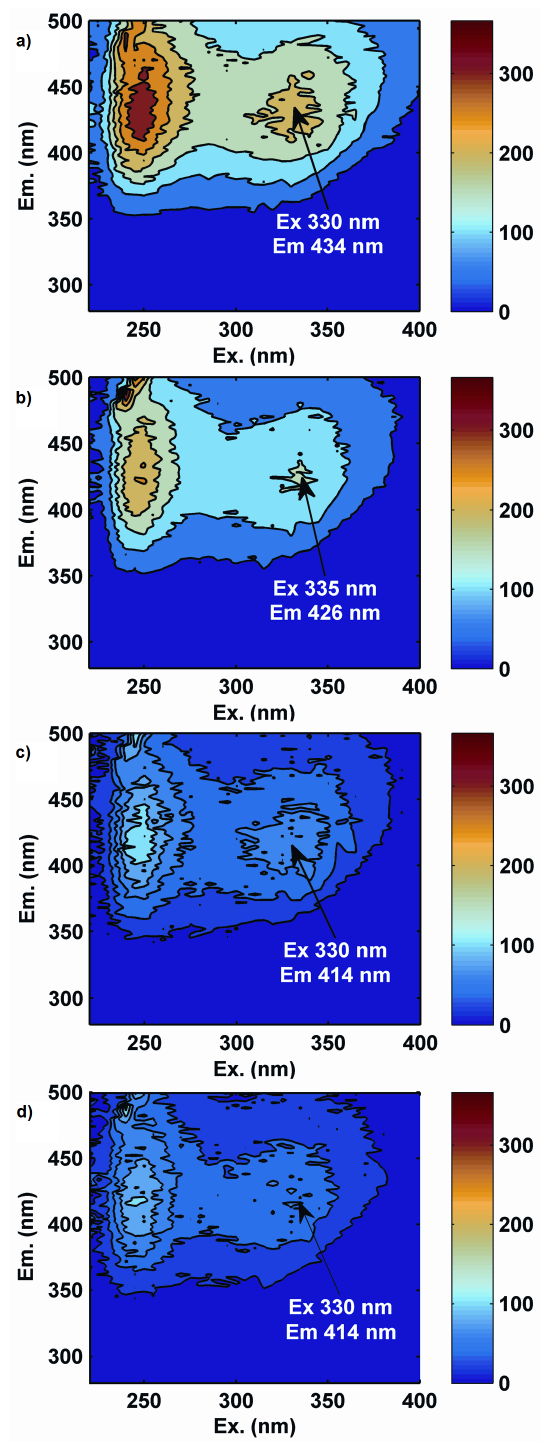
Figure 2. Fluorescence EEMs of raw (a) , post-clarification (b) , post-GAC (c) , and final water (d) at site 13 collected on 5 Au- gust 2007. The location of peak C fluorescence maximum indicated with arrow. Fluorescence emission intensity in arbitrary